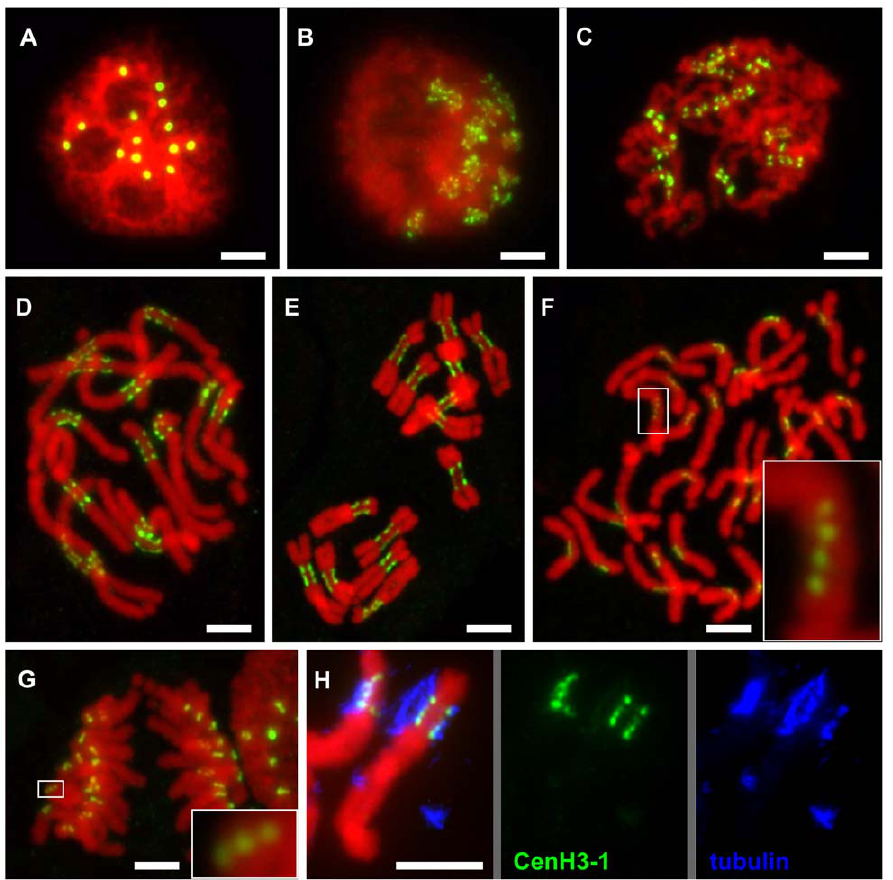
Figure 2. Organization of CenH3-containing domains during the cell cycle. A: Number of CenH3-containing domains in interphase nucleus corresponds to the number of chromosomes in diploid cells (2n=14). B–D: Mitotic chromosomes at the early prophase (B), prophase (C) and prometaphase (D) show multiple domains containing the CenH3 which are clearly separated with chromatin segments lacking the CenH3. E–G: The separation of CenH3-containing domains becomes less apparent with the progress of chromatin condensation: metaphase (E), spread of single- chromatid anaphase chromosomes (F), anaphase (G). However, the multiple domain structure can be observed in some cases even in the highly condensed anaphase chromosomes (detail windows in F and G). H: Simultaneous detection of CenH3-1 (green) and tubulin (blue) revealed that microtubules are attached to all CenH3 containing domains as shown for chromosome 3. All chromosomes were counterstained with DAPI (pseudocolored in red). Bar=5 m